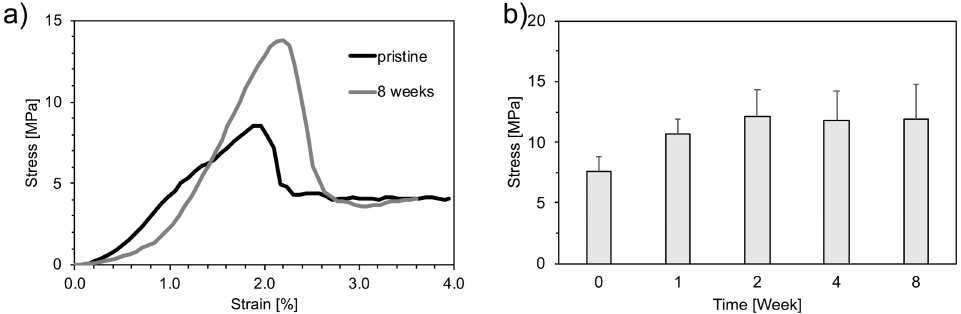
Figure 6. Mechanical tests: ( a ) representative stress–strain compressive behavior of unaged (pristine) and foams aged 8 weeks; ( b ) Stress at break of pristine and aged